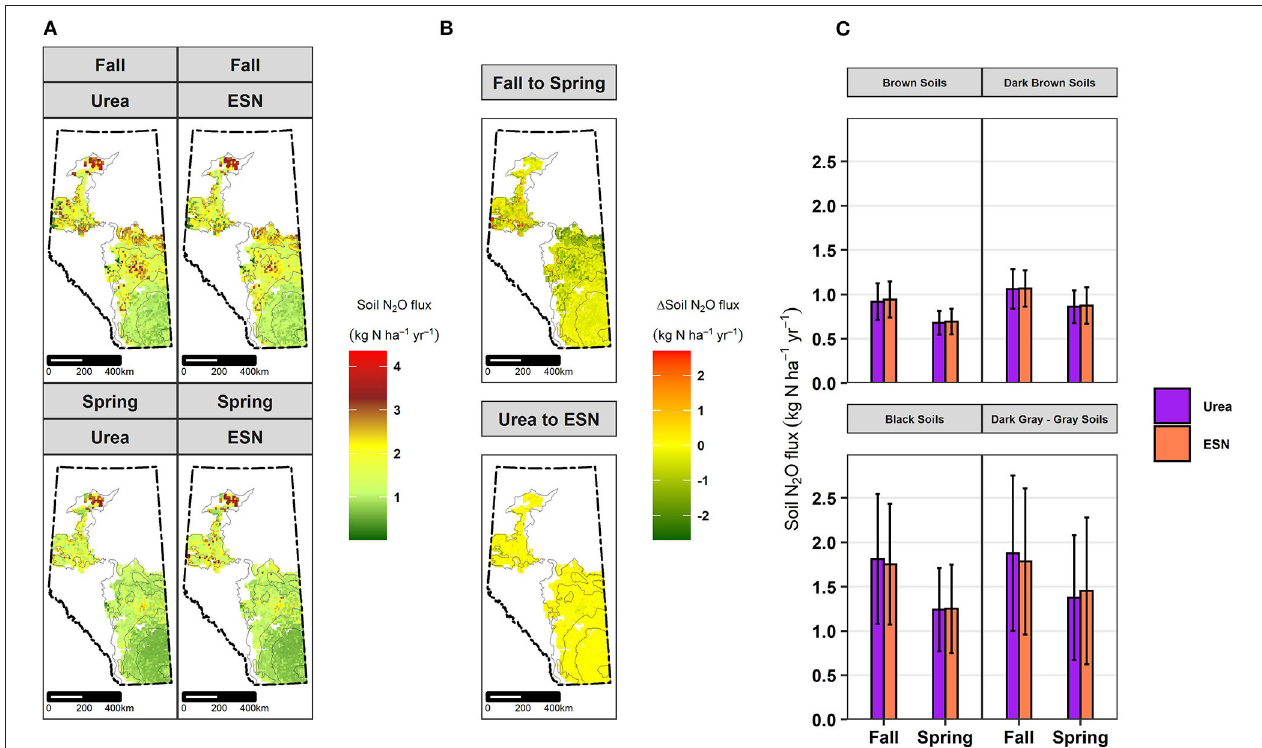
FIGURE 9 | (A) Spatial distribution of modeled annual (January 1–December 31) soil N 2 O fluxes averaged over the simulation period (2011–2015) for each township for each of the fall and spring banded urea and ESN applications across mid-slope landforms of Alberta under simulated barley cultivation. Positive fluxes represent emissions and vice versa. (B) Spatial distribution of differences in modeled annual soil N 2 O fluxes for fall vs. spring and urea vs. ESN applications averaged over the simulation period (2011–2015) for each township across mid-slope landforms of Alberta under simulated barley cultivation. A positive change represents an increase in N 2 O fluxes for a change from fall to spring or from urea to ESN and vice versa. The white areas on the map were not modeled based on the selection criteria as described in section Methodology and Model Inputs. The thick dashed lines on the maps represent Alberta’s provincial boundary, and the thin black lines within the maps demarcate soil group areas. (C) Soil group-wise averages of modeled annual soil N 2 O fluxes for fall vs. spring banding and urea vs. ESN applications averaged over the simulation period (2011–2015) for all the townships in each soil group area across mid-slope landforms of Alberta under simulated barley cultivation. Error bars represent standard deviations illustrating spatiotemporal variations in modeled annual soil N 2 O fluxes within each soil group